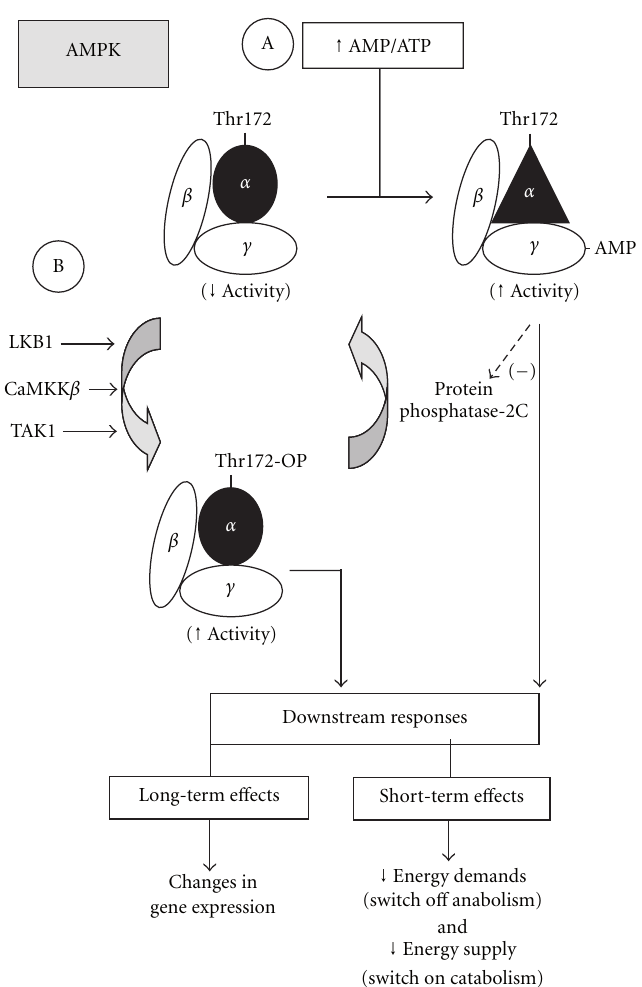
Figure 1: Regulation of AMP-activated protein kinase (AMPK) by (A) direct allosteric activation and (B) reversible phosphorylation and downstream responses maintaining intracellular energy balance. Abbreviations: LKB1, tumor suppressor LKB1 kinase; CaMKK β , Ca 2+ - calmodulin-dependent kinase kinase- β ; TAK1, transforming growth-factor- β -activated